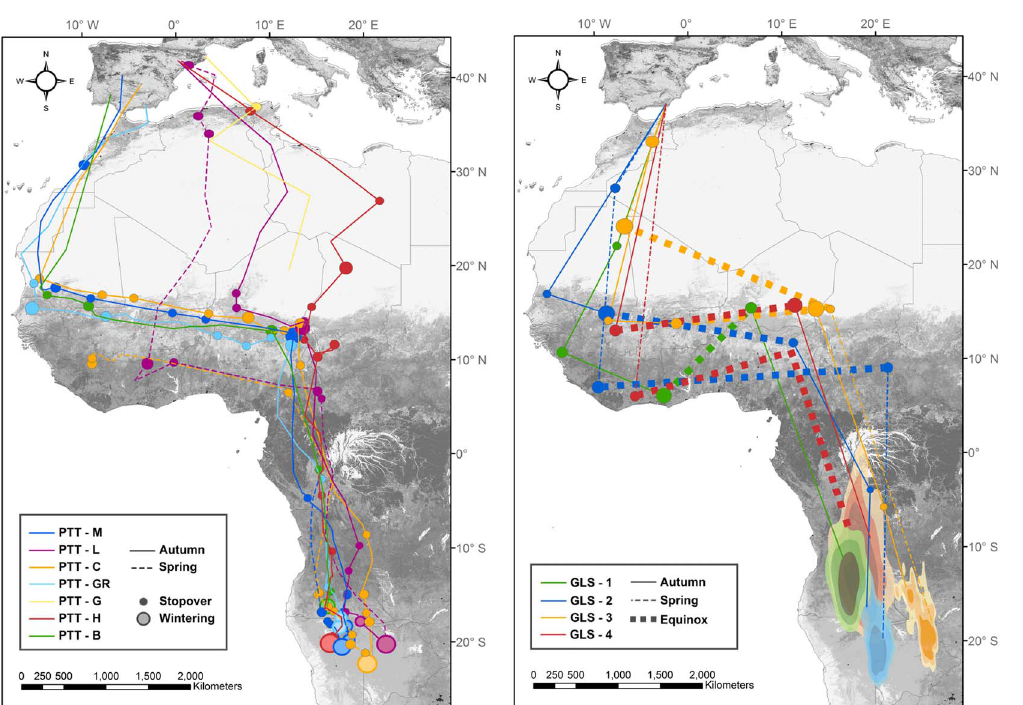
Fig. 1. Migratory routes, stopover sites and wintering grounds of southwestern European Rollers. Tracks recorded by satellite tranmitters (left) and geolocators (right) between breeding sites in the Iberian Peninsula and the wintering grounds (blue dots and blue areas, respectively) in southwestern Africa. Red and green colours correspond, respectively, to autumn and spring migrations. Dots represent stopovers, and their sizes are relative to time spent (the longer the period, the bigger the spot). Dotted lines indicate uncertainty provoked by the equinoxes. Locations assigned before and after dotted lines are partially based on longitudinal data and should be considered as approximations. Geolocators data for latitudes close to the equator have high associated deviations and thus should be interpreted carefully [45]. Wintering grounds for satellite-tracked birds were located by calculating average coordinates, whilst for geolocators they were calculated by kernel density estimation for 50, 70 and 90% of the